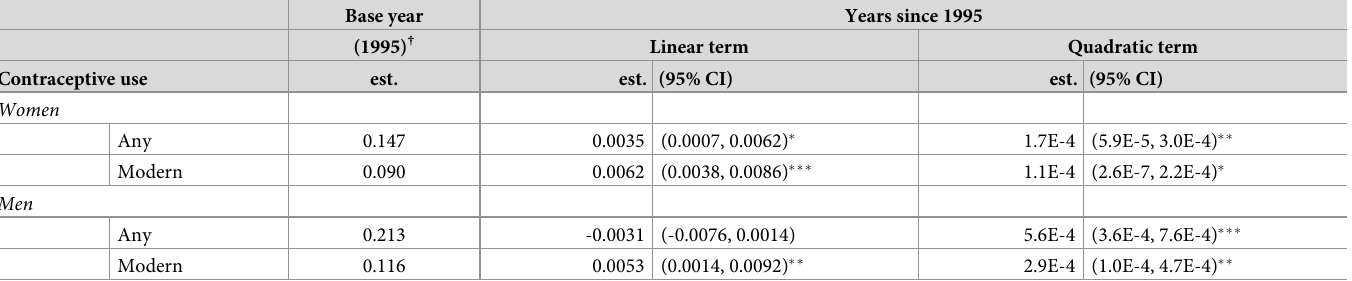
Table 1. Estimates together with associated 95% CIs for regression models of any and modern contraceptive use among women and men in Uganda over the years 1995 to